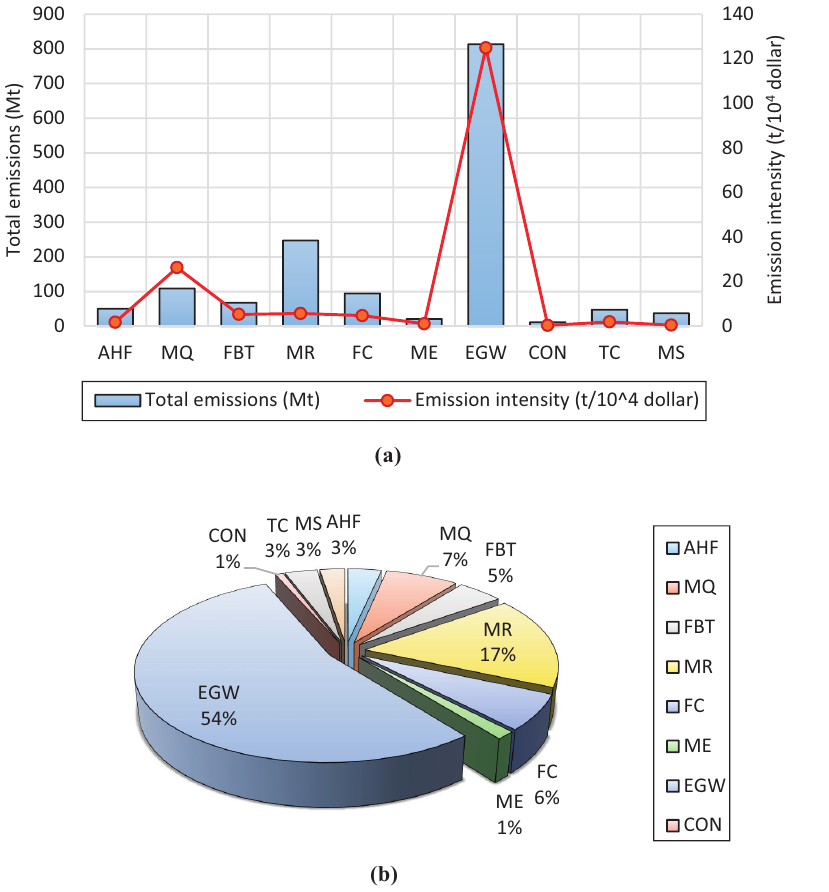
Figure 1. (a) Total carbon emissions and intensities and (b) block-wise ratio of total carbon